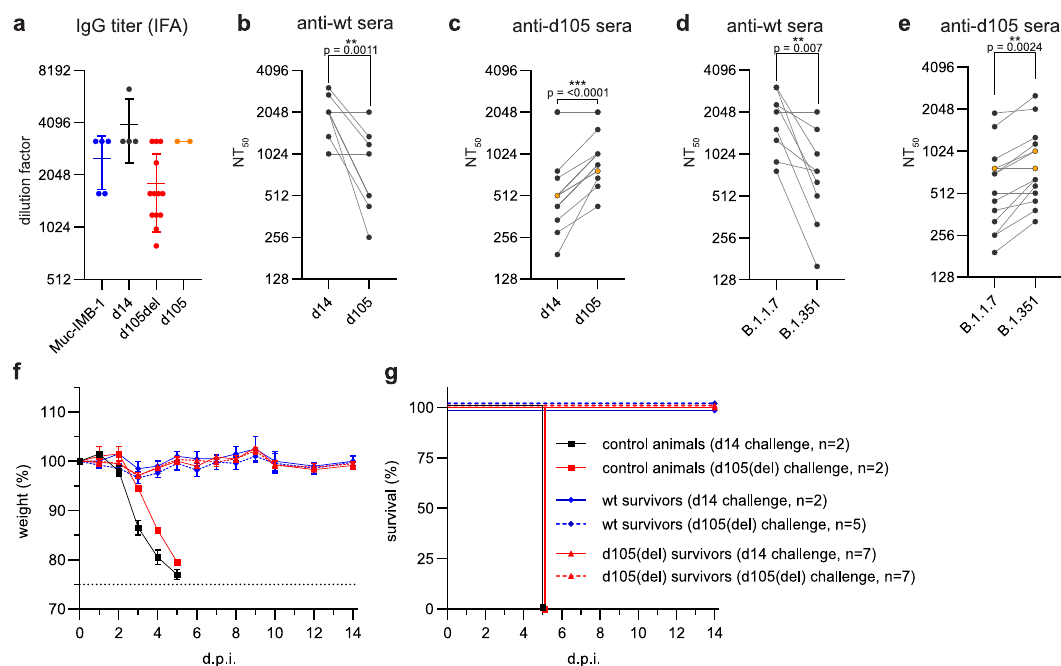
Fig. 6 Late SARS-CoV-2 d105 isolate elicits cross-reactive protective immunity in mice. Sera were collected from convalescent K18-hACE2 mice at least 21 days post-infection with Muc-IMB-1 ( n = 5 blue), d14 ( n = 4), d105(del) ( n = 13, red) or d105 ( n = 2, orange) virus isolates. a Anti-SARS-CoV-2 IgG titers of serially diluted sera (mean ± SD) were determined using virus-infected cells and indirect immuno fl uorescence analysis (IFA). b , c Neutralization of d14 and d105 virus isolates by convalescent mouse sera obtained after infection with wild-type SARS-CoV-2, d14 and Muc-IMB-1 (anti-wt sera, n = 9) ( b ), or with variant d105 virus isolate (pooled data using anti-d105 ( n = 2, orange) and anti-d105(del) sera ( n = 13, black)) ( c ). Neutralization capacity was determined by incubating 400 pfu of either virus isolate with serial dilutions of the mouse sera. The mixture was then applied to VeroE6 cells and infected cells were stained with N-speci fi c antibodies. d , e Neutralization of B.1.1.7 and B.1.351 variants of concern by mouse convalescent sera was determined as described in panels b and c . Neutralization titers, NT 50 , are meant as the highest dilution for each individual serum causing 50% reduction of infectivity. Each serum titer ( b – e ) is shown as the mean out of two independent experiments. Signi fi cance was determined via a two-tailed, paired t test with * p < 0.05, ** p < 0.01, *** p < 0.001. The exact p -values are given in the fi gure. f , g Convalescent animals are protected against re-challenge infection. Weight loss ( f ) and survival ( g ) of convalescent K18-hACE2 mice (mean± SEM), challenged one to four months after the prime infection. Animals primarily infected with d14 and Muc-IMB-1 viruses (pooled wt survivors, n = 7), or with d105(del) virus ( n = 14) were intranasally challenged with 100,000 pfu of d14 or d105(del) viruses (2 – 7 mice per group, as indicated). As a control, naïve 8 weeks old K18-hACE2 mice were intranasally infected with 100,000 pfu of d14 or d105(del) isolate viruses ( n = 2 per group). Source data are provided as a Source Data fi